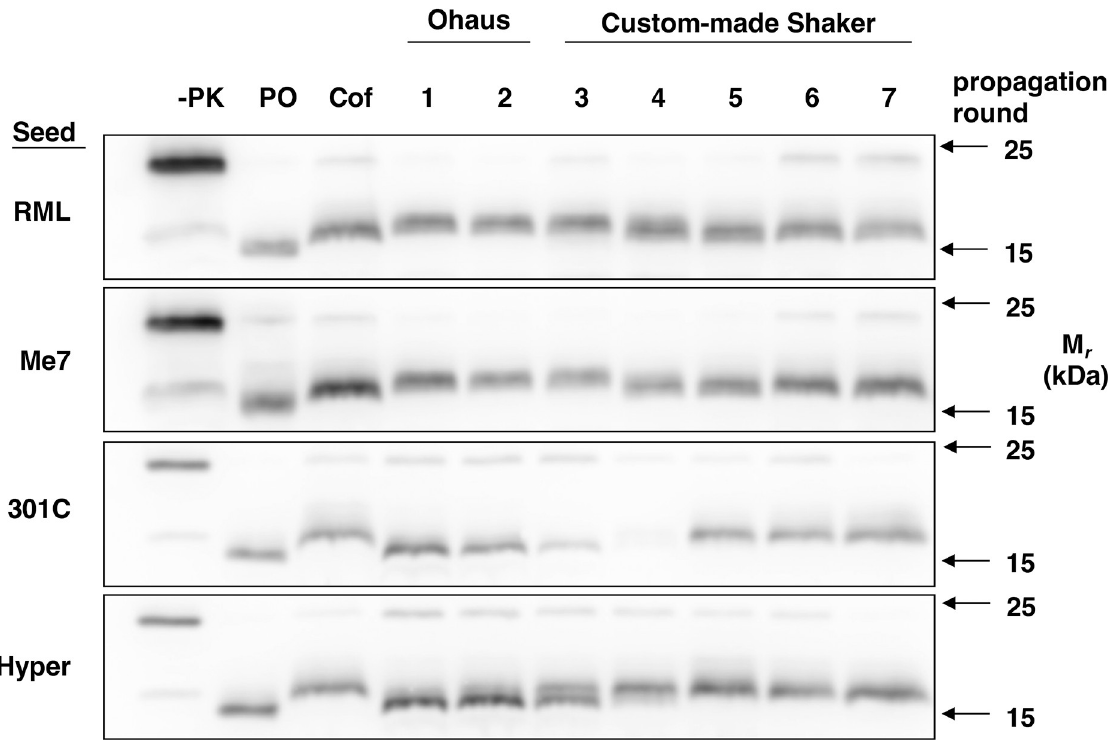
Fig 4. Effect of different shaking conditions on BV recPrP Sc variants. Western blots showing adaptation of BV recPrP Sc variants during serial propagation at lower shaking speed. All reactions were propagated in a substrate cocktail containing BV recPrP plus purified phospholipid cofactor. Reactions were initially seeded with RML, Me7, 301C, or Hyper as indicated. Blots show two rounds of serial propagation with continuous shaking in a commercial Ohaus shaker with 3 mm orbit at 2,000 rpm followed by 5 additional rounds of serial propagation in a custom-made shaker with 8 mm orbit at 1,200 rpm. Reference shaking-generated protein-only PrP Sc (PO) and cofactor PrP Sc (Cof) samples are included on each blot for MW comparison. (-PK) = Custom-made shaker round 7 samples not subject to proteinase K digestion; all other samples were